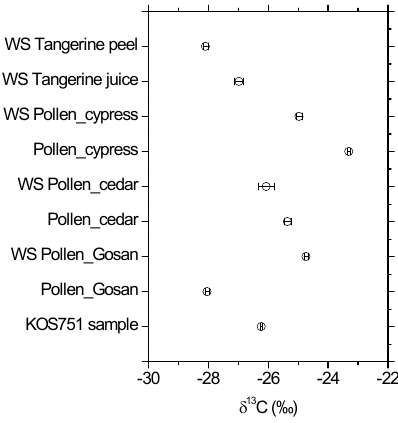
Fig. 8. δ 13 C TC values in the airborne pollen collected at the Gosan site (Pollen Gosan ), authentic standard pollens from Japanese cedar and Japanese cypress, tangerine fruit, and the filter sample collected during the severe pollen episode (KOS751). WS represents water- soluble fraction of the samples. The error bar represents the stan- dard deviation of the duplicate analyses of the